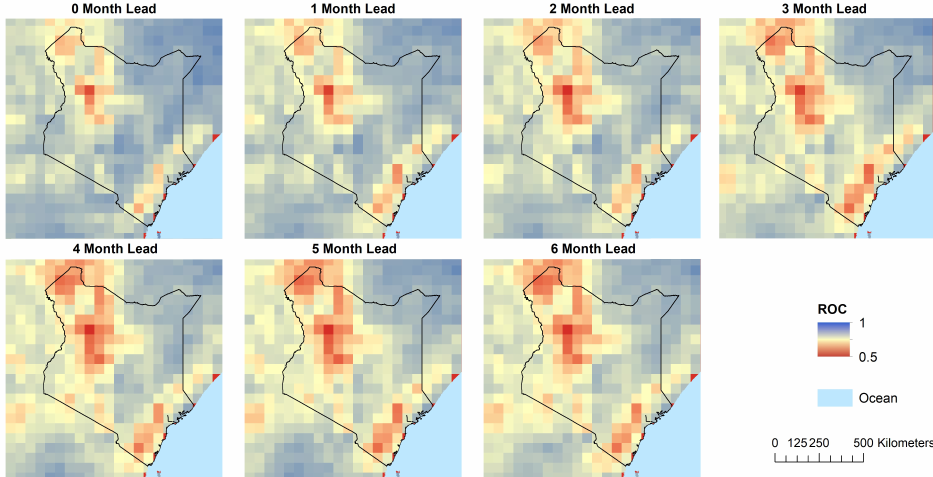
Figure 6. This image shows the ROC for dry anomaly events.